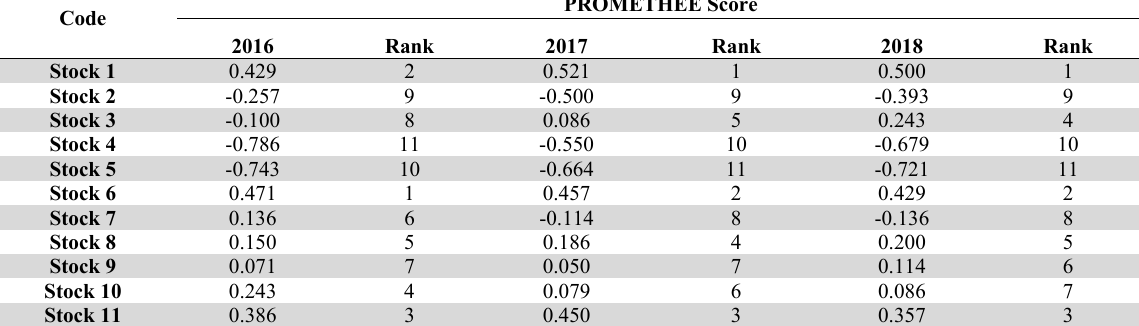
Ranking Results with Sustainable Certification and Risk